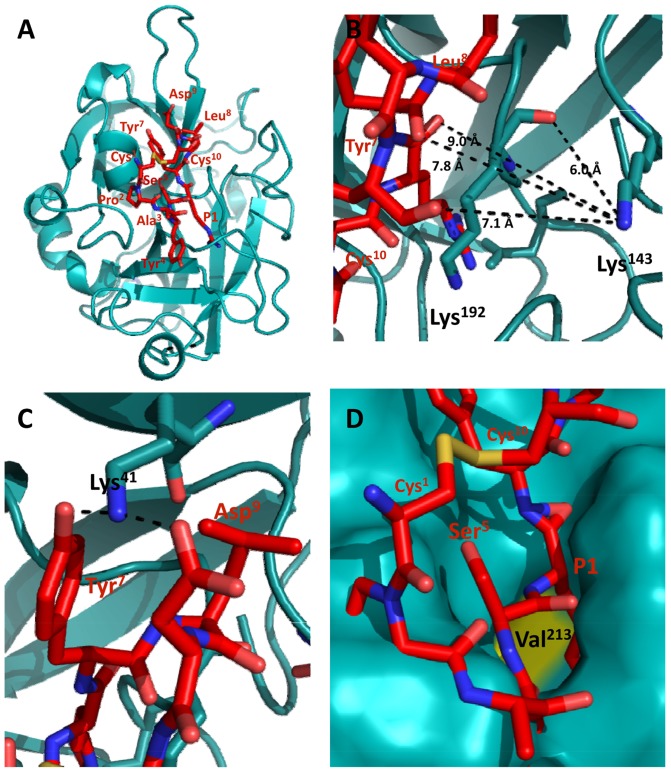
Structural model of mupain-1 in complex with muPA.(A) Overall model of the complex between muPA (teal ribbon presentation) and mupain-1 (red stick representation). The enzyme is shown in teal cartoon presentation. (B) A zoom on the Lys143 area of the model, showing distances from Lys143 to the closest atoms in the peptide. (C) A zoom on the Lys41 area of the model, showing the distances between Lys41 and peptide residues Tyr7and Asp9. (D) A zoom on the entrance to the S1 pocket of the model, with Val213 at the entrance indicated; the enzyme is represented as teal surface. huPA-H99Y residues are labelled with black letters, peptide residues with dark red letters.